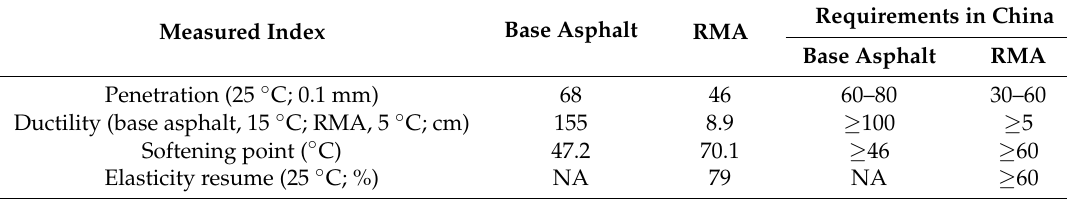
Table 4. Basic technical properties of base asphalt and RMA.